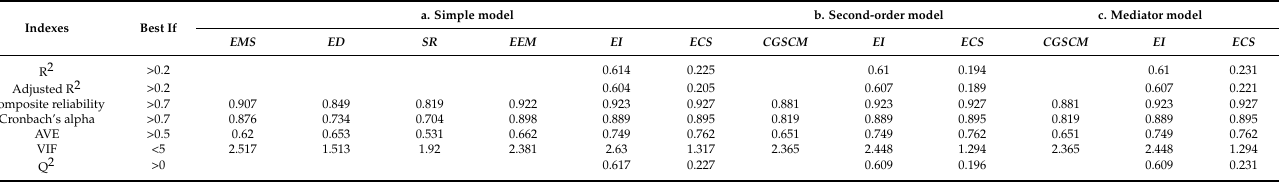
Table 3. Latent variable coefficients.